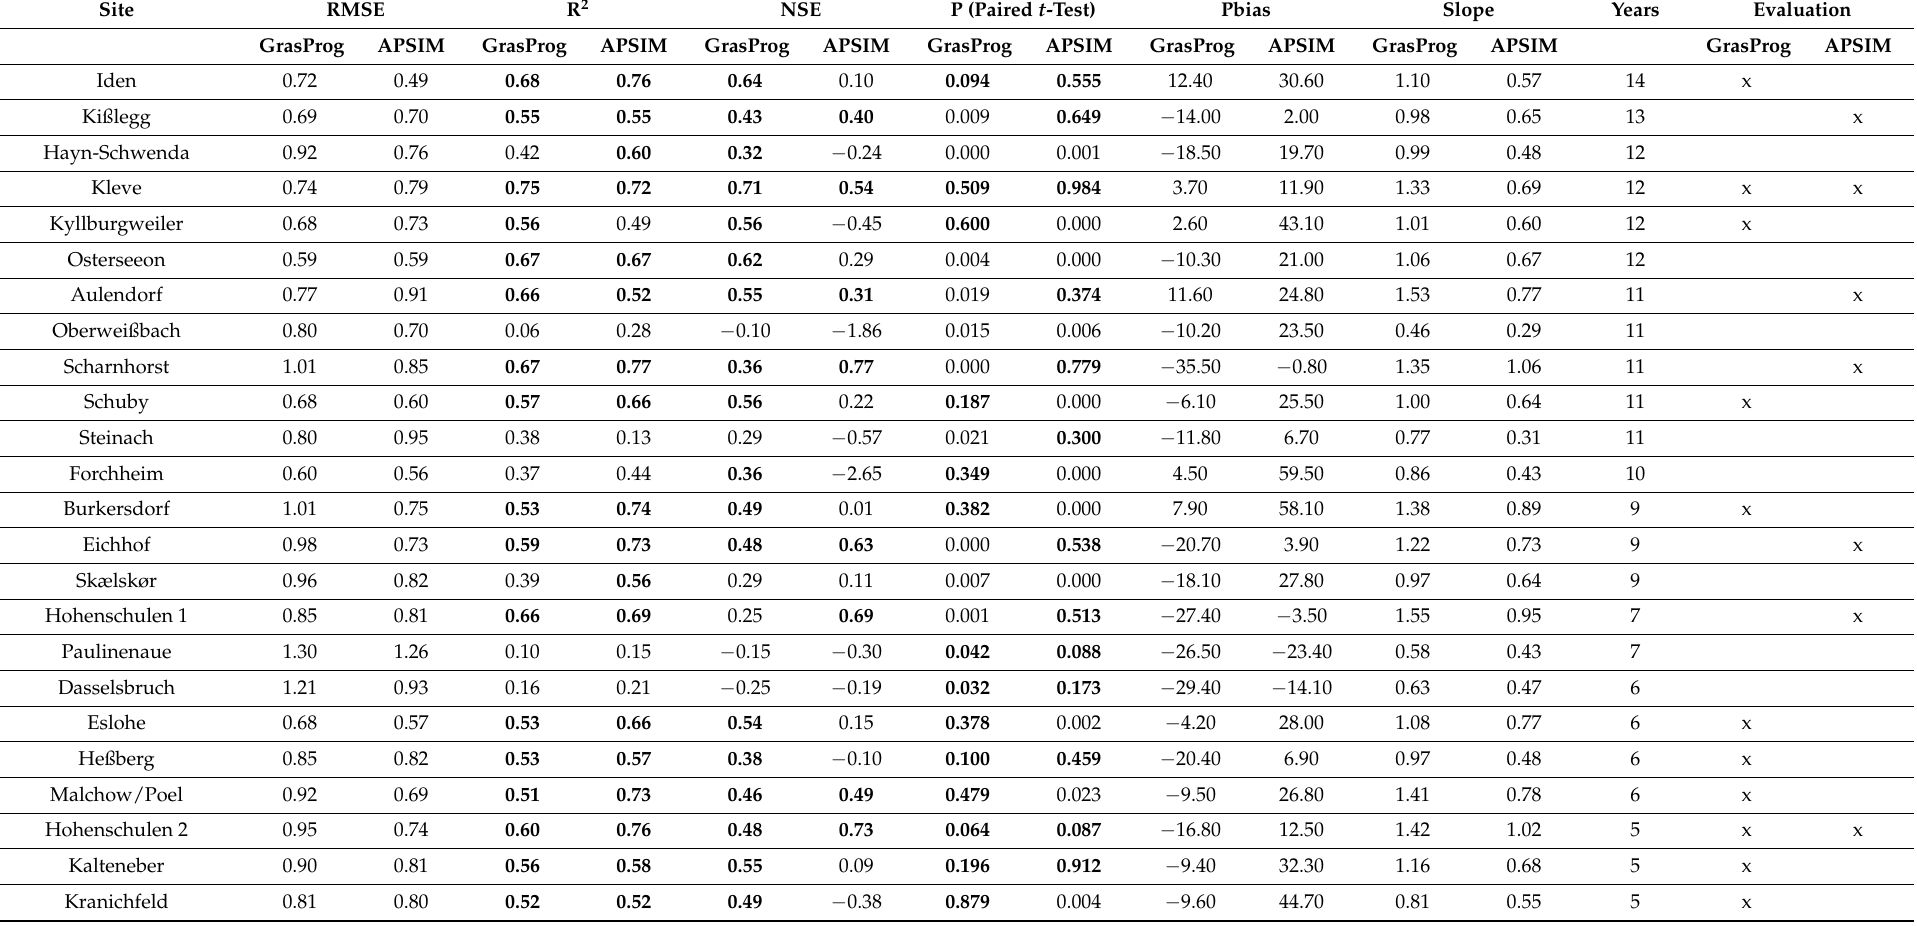
Table 2. Model performance statistics GrasProg1.0 and APSIM for individual cuts with data from variety trials from national trials in Germany and Denmark, spanning different numbers of years. Bold numbers indicate good model performance (NSE > 0.3, R 2 > 0.5, and p > 0.025), and x indicates if the model satisfies all three